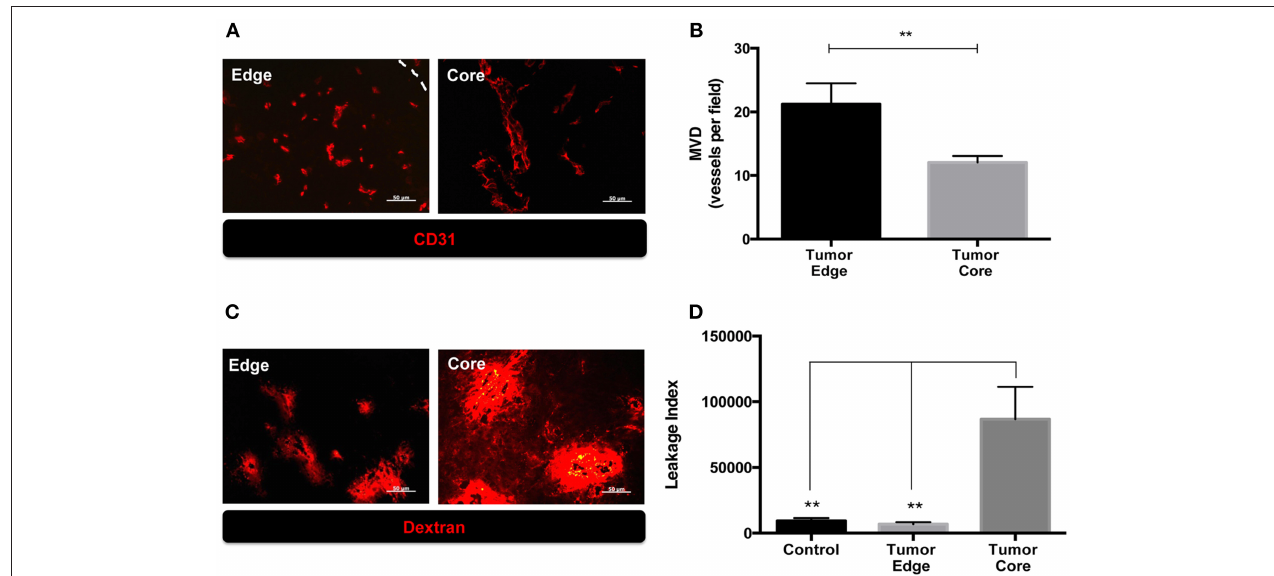
FIGURE 1 | The microenvironment of tumor edge had higher microvascular density as well as better vascular function than those of tumor core in orthotopic ALTS1C1 tumors. Tumor sections at day 21 were stained with endothelial cell marker, CD31, and quantified. (A) Representative figures of CD31 + vessels in tumor core and edge. Tumor edge was defined as the distance of 200 µ m inward from the tumor’s boundary marked by white dotted line. (B) MVD was defined as the number of CD31 + vessels per field under 40X magnification. At least 10 fields per section were analyzed. Three sections of each tissue was calculated. Each group had at least three mice for data analysis. (C) The integrity of vasculatures in brain tissues injected with PBS (control) and ALTS1C1 tumor cells was examined by 70 kDa dextran distribution. (D) Leakage index was defined as the ratio of the signals (pixels) of dextran to the number of CD31 + vessels. All data points were analyzed in triplicate and values displayed are means ± SDs. The significant difference of treatment groups were compared with control group and analyzed by ANOVA. ** P < 0.01. Scale bar = 50 µ m.